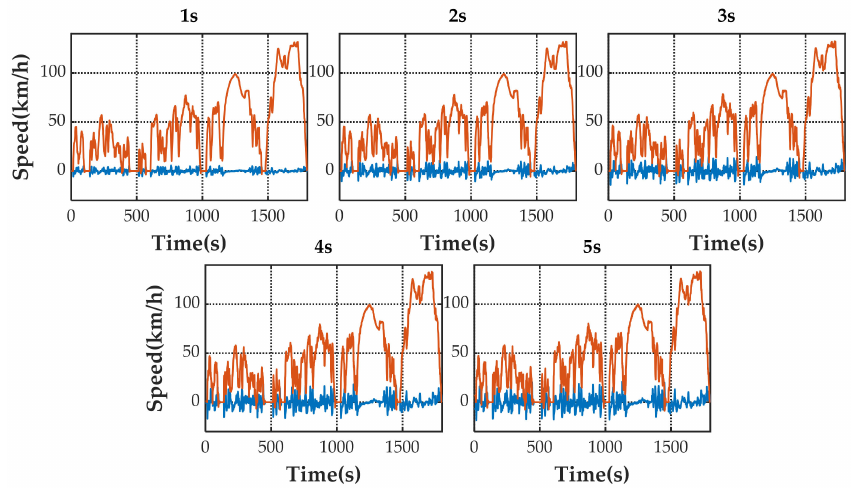
Figure 9. The prediction error (blue) and prediction speed (orange) of